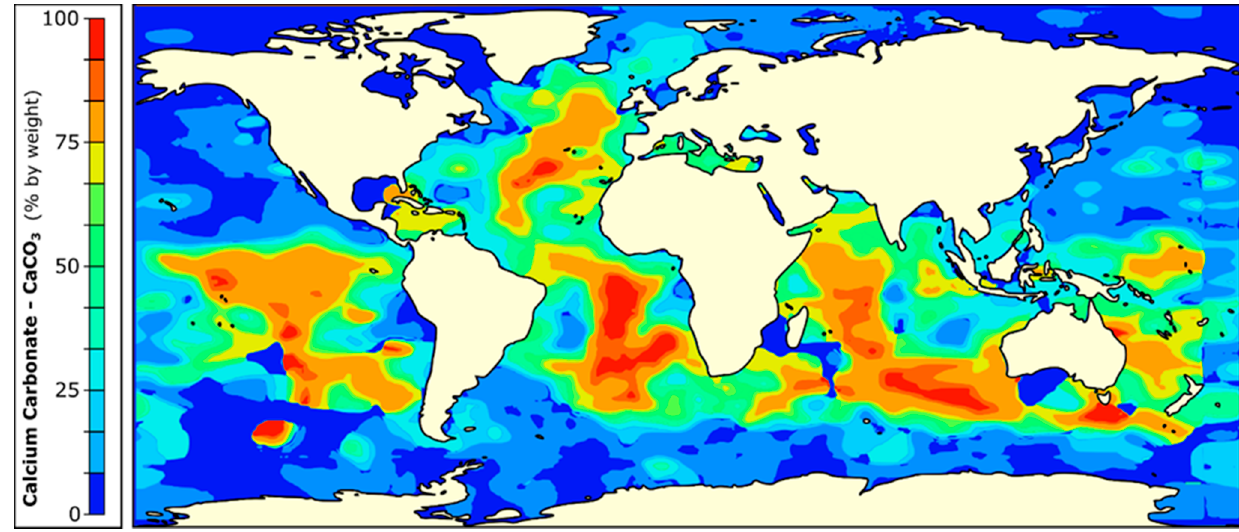
Figure 2. Carbonate sediments in offshore locations.